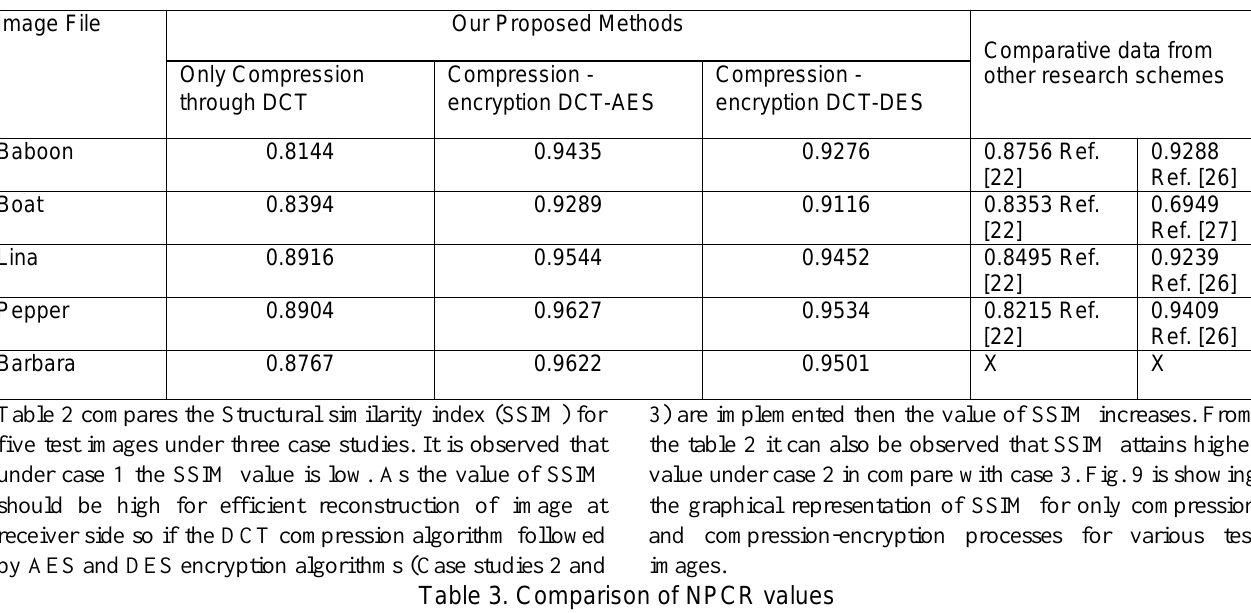
Table 3. Comparison of NPCR values